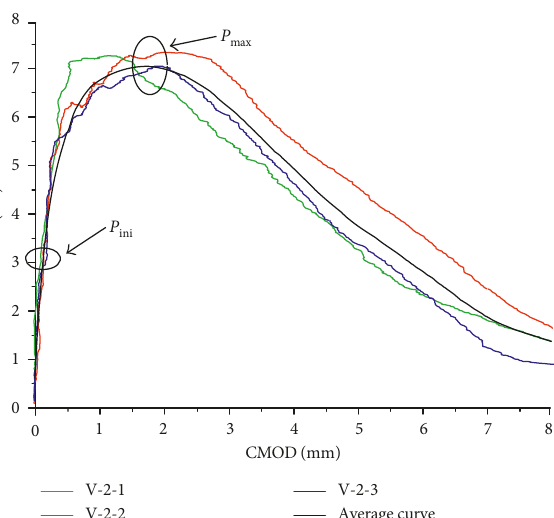
Figure 3: Matrix of P -CMOD curves under static load. Figure